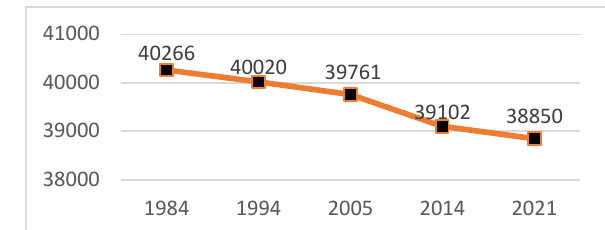
Figure 4. The diagram of forest changes from 1984 to 2021 in the study area (hectares).